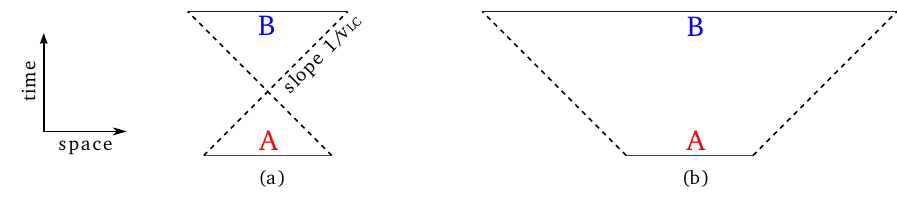
Figure 5 . If B is smaller than shown in (a), the lower bound and the holographic answer indicate that B contains none of the information in A . If B is larger than shown in (b), it contains all of the information in A . The dashed lines are v LC cones, not light